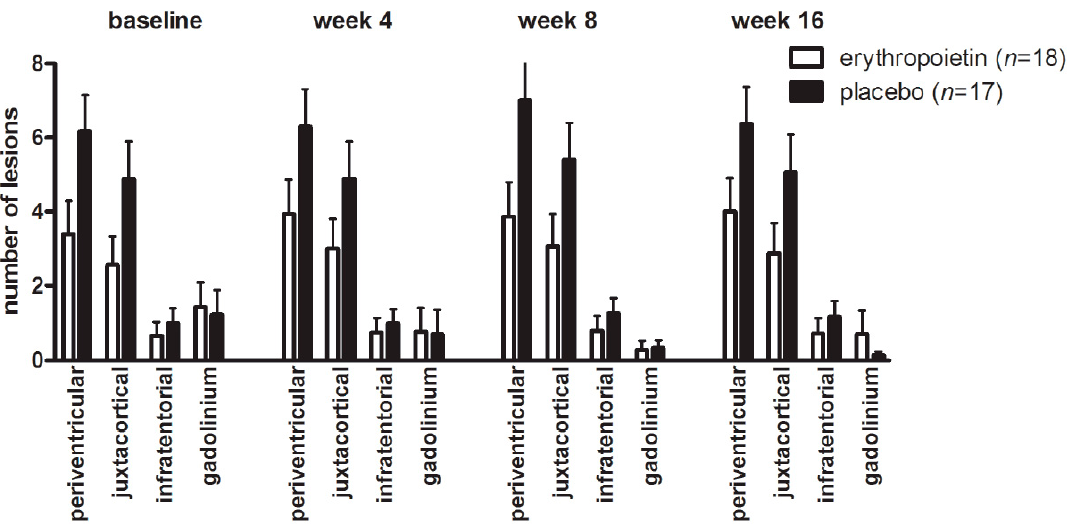
Figure 1. Cranial MRI lesion load. Mean T2 lesion load aligned by lesion site and gandolinium enhancing lesions at different time points. Empty bars = erythropoietin; black bars= placebo; error bars = SEM.